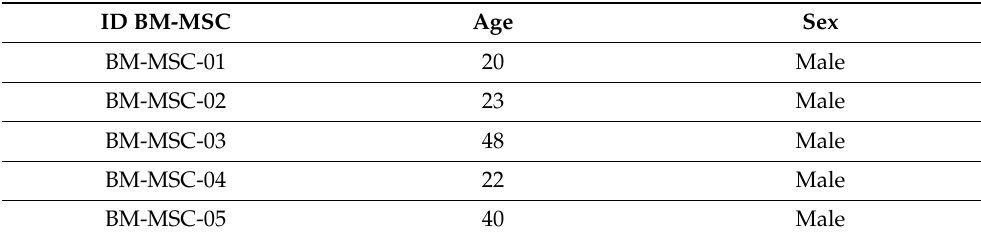
Table 1. MSCs donors’ age and